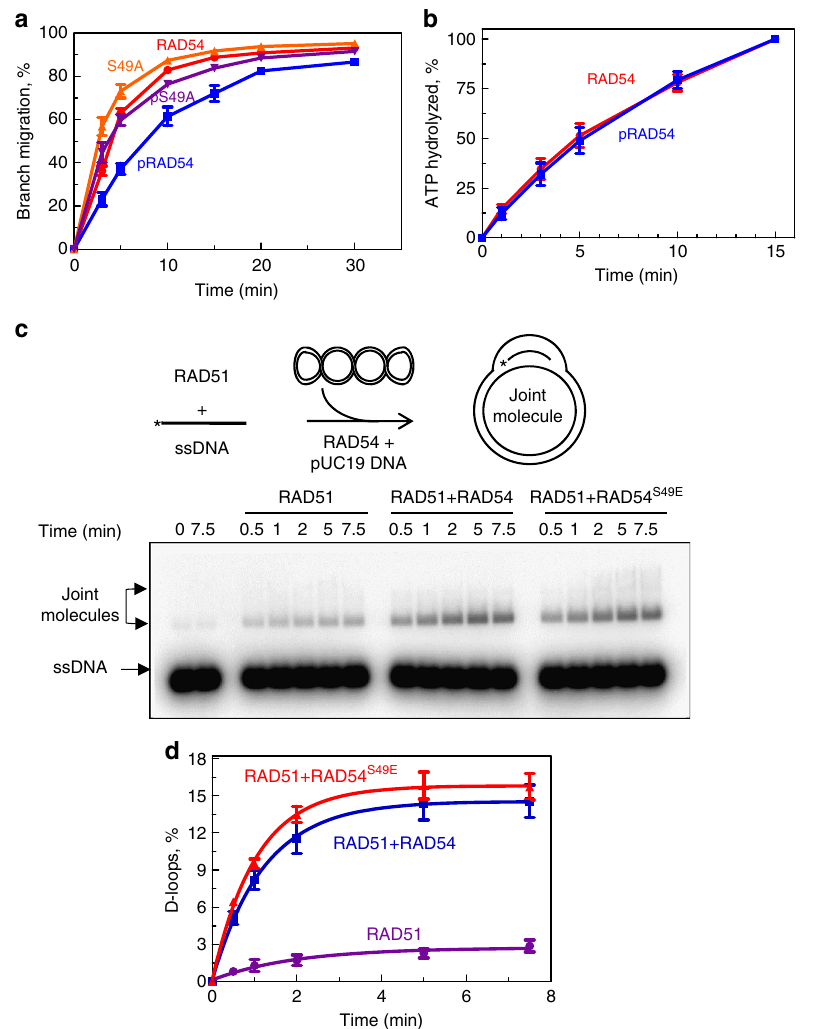
Fig. 6 Effect of CDK2 phosphorylation on the RAD54 activities. a The kinetics of BM of PX junction (no. 71/169/170/171; 10 nM) promoted by RAD54 (60 nM), phosphorylated RAD54 (60 nM), RAD54 S49A (60 nM), or phosphorylated RAD54 S49A (60 nM). b The effect of RAD54 phosphorylation (60 nM) on